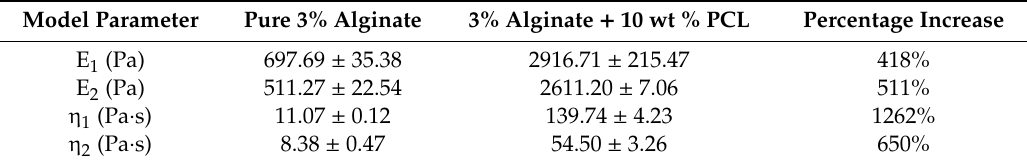
Table 13. Influence of 10% PCL fiber fragments on the Burgers model parameters of 3% ( w / v ) alginate.